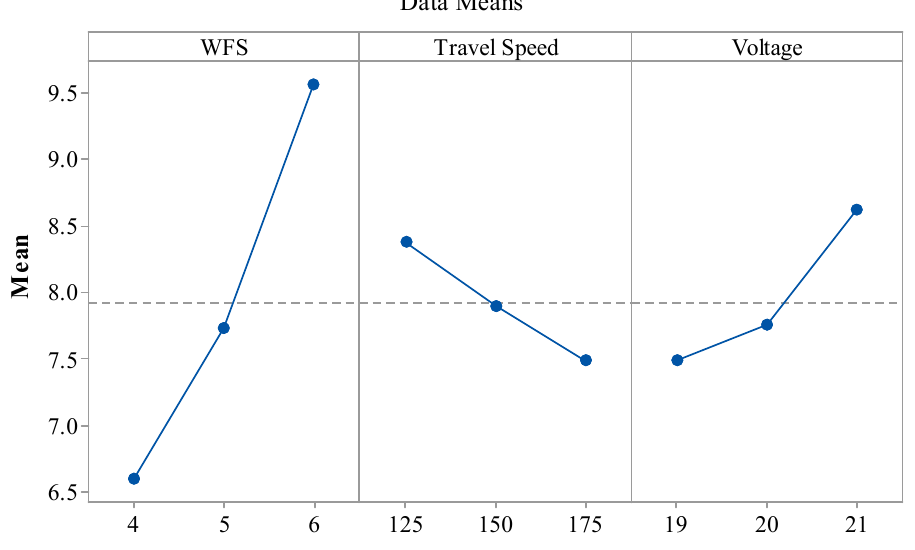
Figure 7. Main effect plot for bead width.